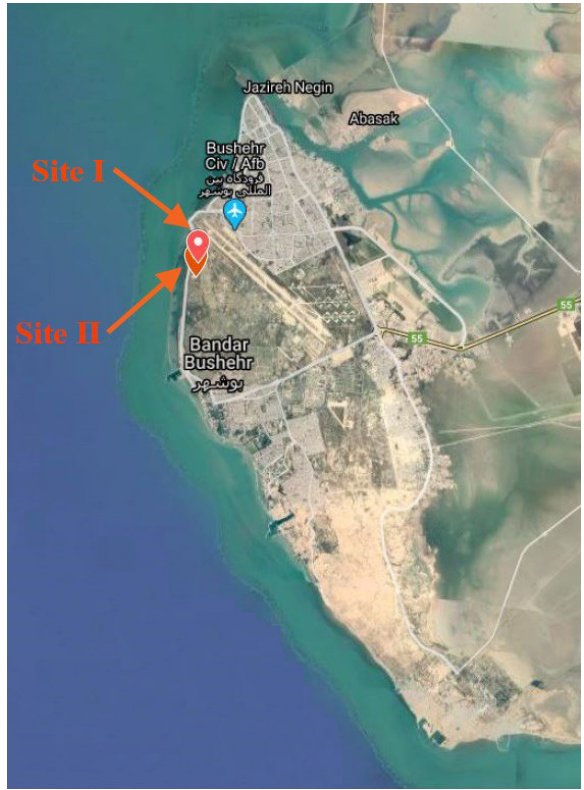
Figure 1. Research study sites [45].